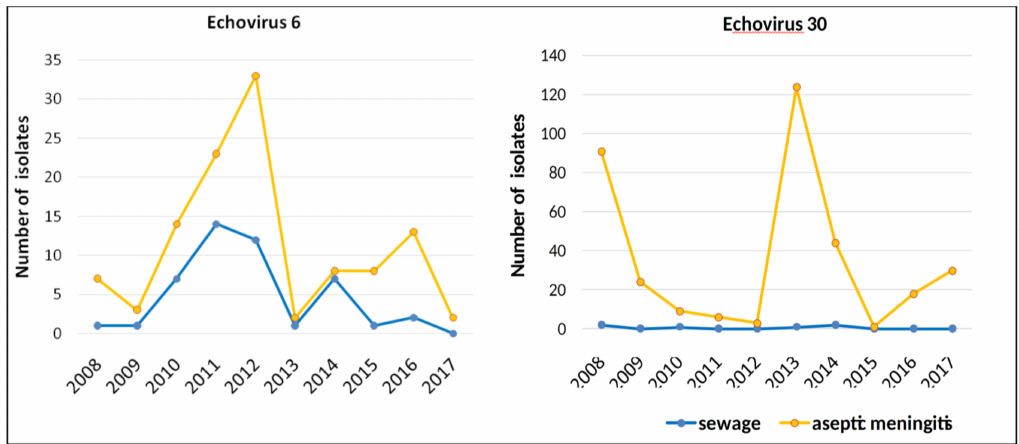
Figure 6. The dynamics of isolation of E6 and E30 from sewage and from cases of aseptic meningitis in Moscow, 2008–2017, by